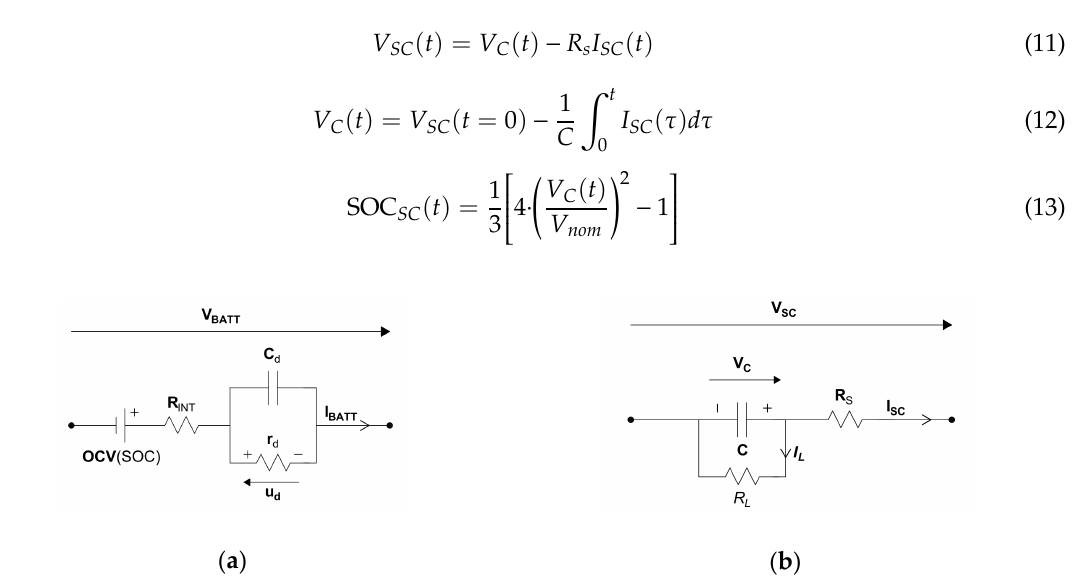
Figure 4. Equivalent circuit of the battery pack ( a ) and SC pack ( b ).